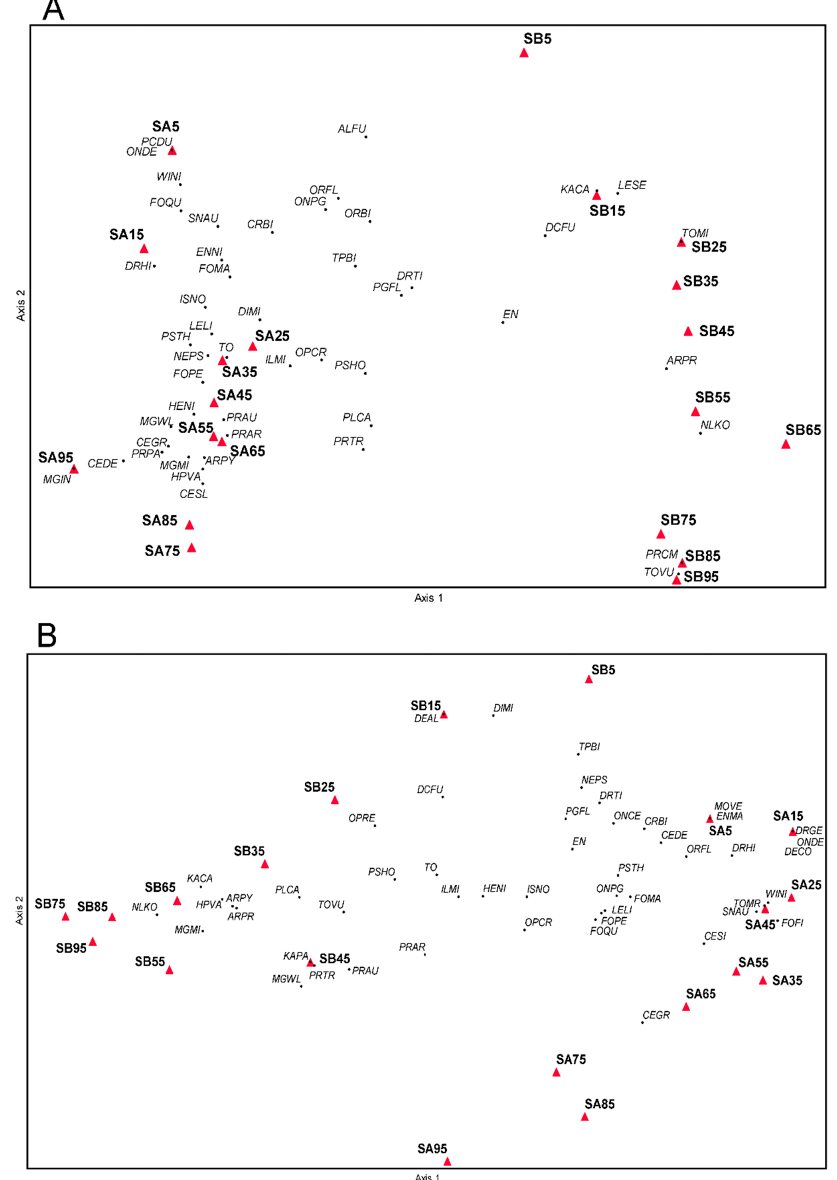
Figure 5. NMS ordination of collembolan communities at sites of a forested scree slope in the Zádiel Valley in two periods; ( A ) warm period, ( B ) cold period; 5–95—soil/scree depth [cm], ALFU— Allacma fusca , ARPR— Pygmarrhopalites principalis , ARPY— P. pygmaeus , CEDE— Ceratophysella denticulata , CEGR— C. granulata , CESI— C. sigillata , CESL— C. silvatica , CRBI— Proisotomodes bipunctatus , DCFU— Dicyrtoma fusca , DEAL— Deutonura albella , DECO— D. conjuncta , DIMI— Dicyrtomina